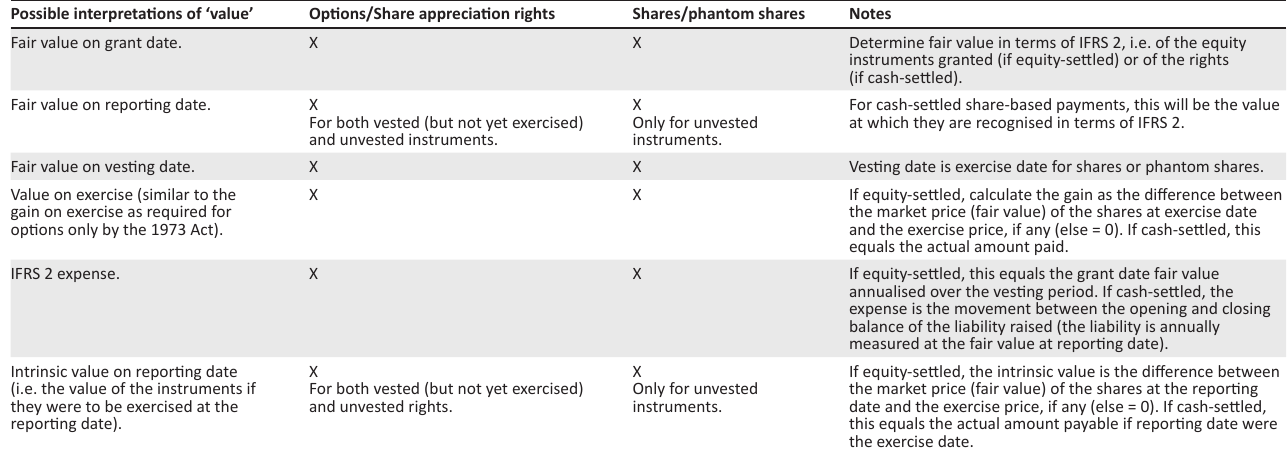
TABLE 4: Possible interpretations of